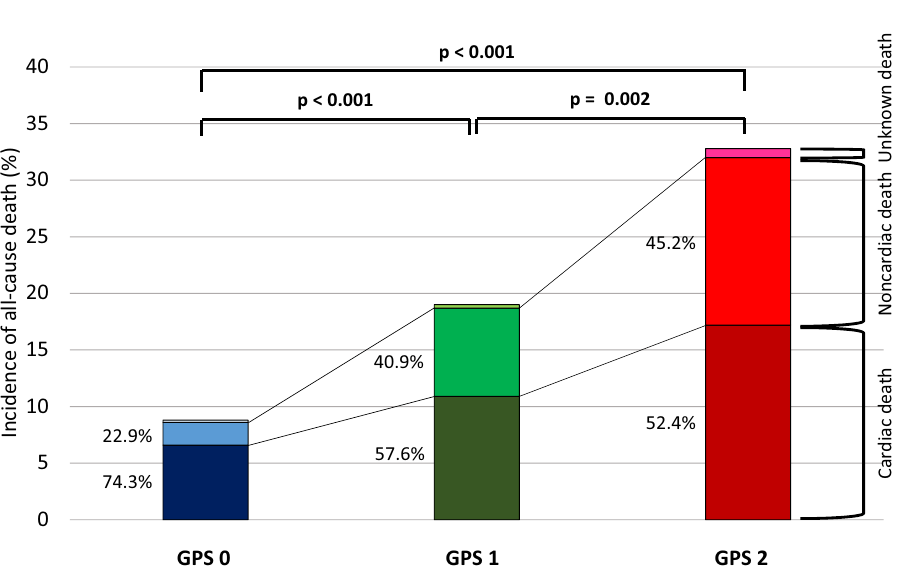
Figure 2. Incidence of all-cause death stratified by GPS and cause of deaths. Higher incidence of all-cause, cardiac and noncardiac mortality was observed with increasing GPS. GPS Glasgow Prognostic